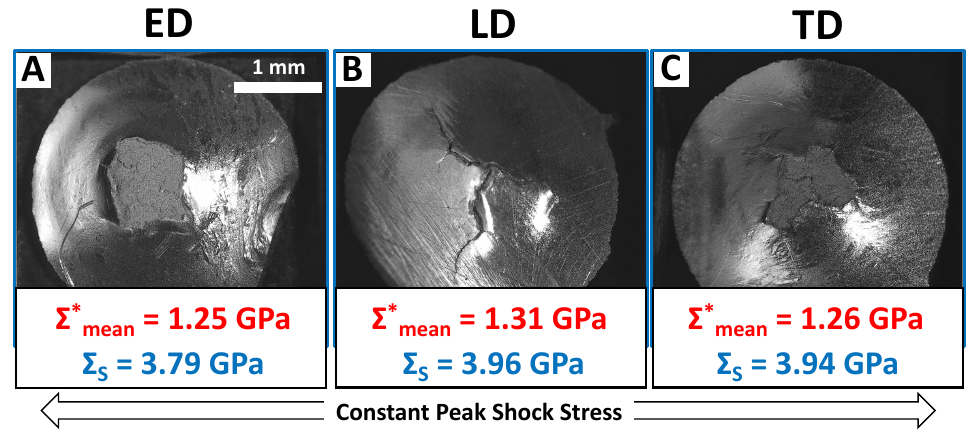
Figure 7. Orientation-dependent macroscopic damage morphology. Sample 9A ISO macroscopic free-surface spall damage in ( A ) ED, ( B ) LD, and ( C ) TD at nominally constant Σ S